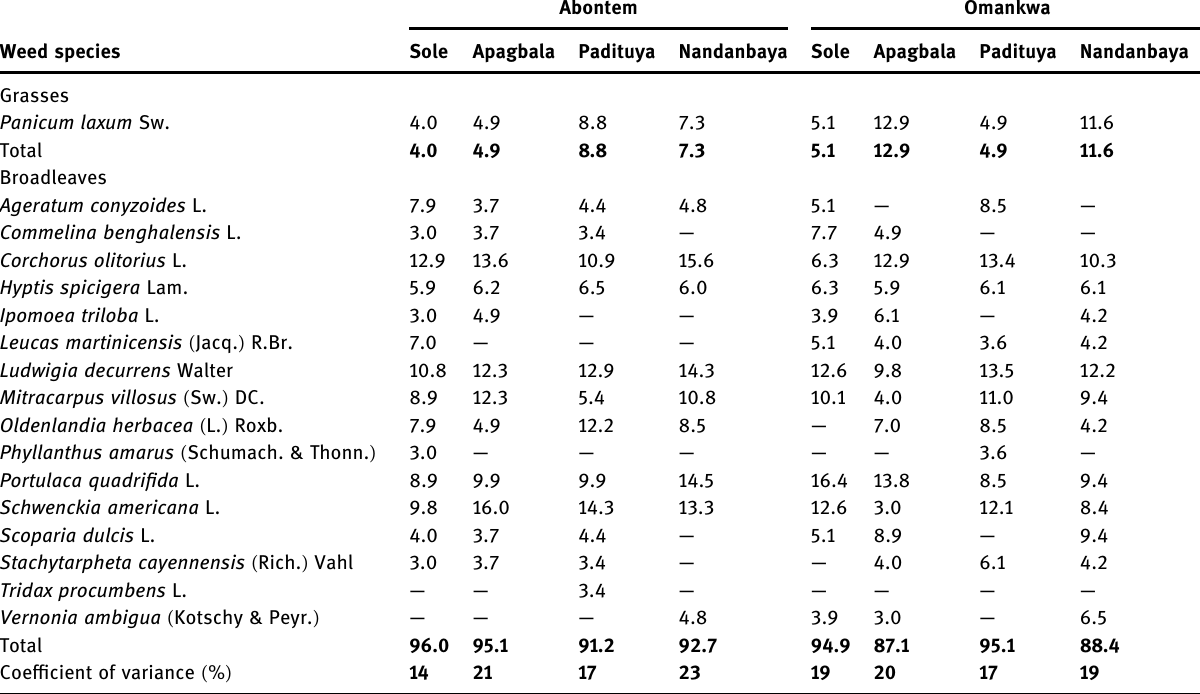
Abontem Omankwa